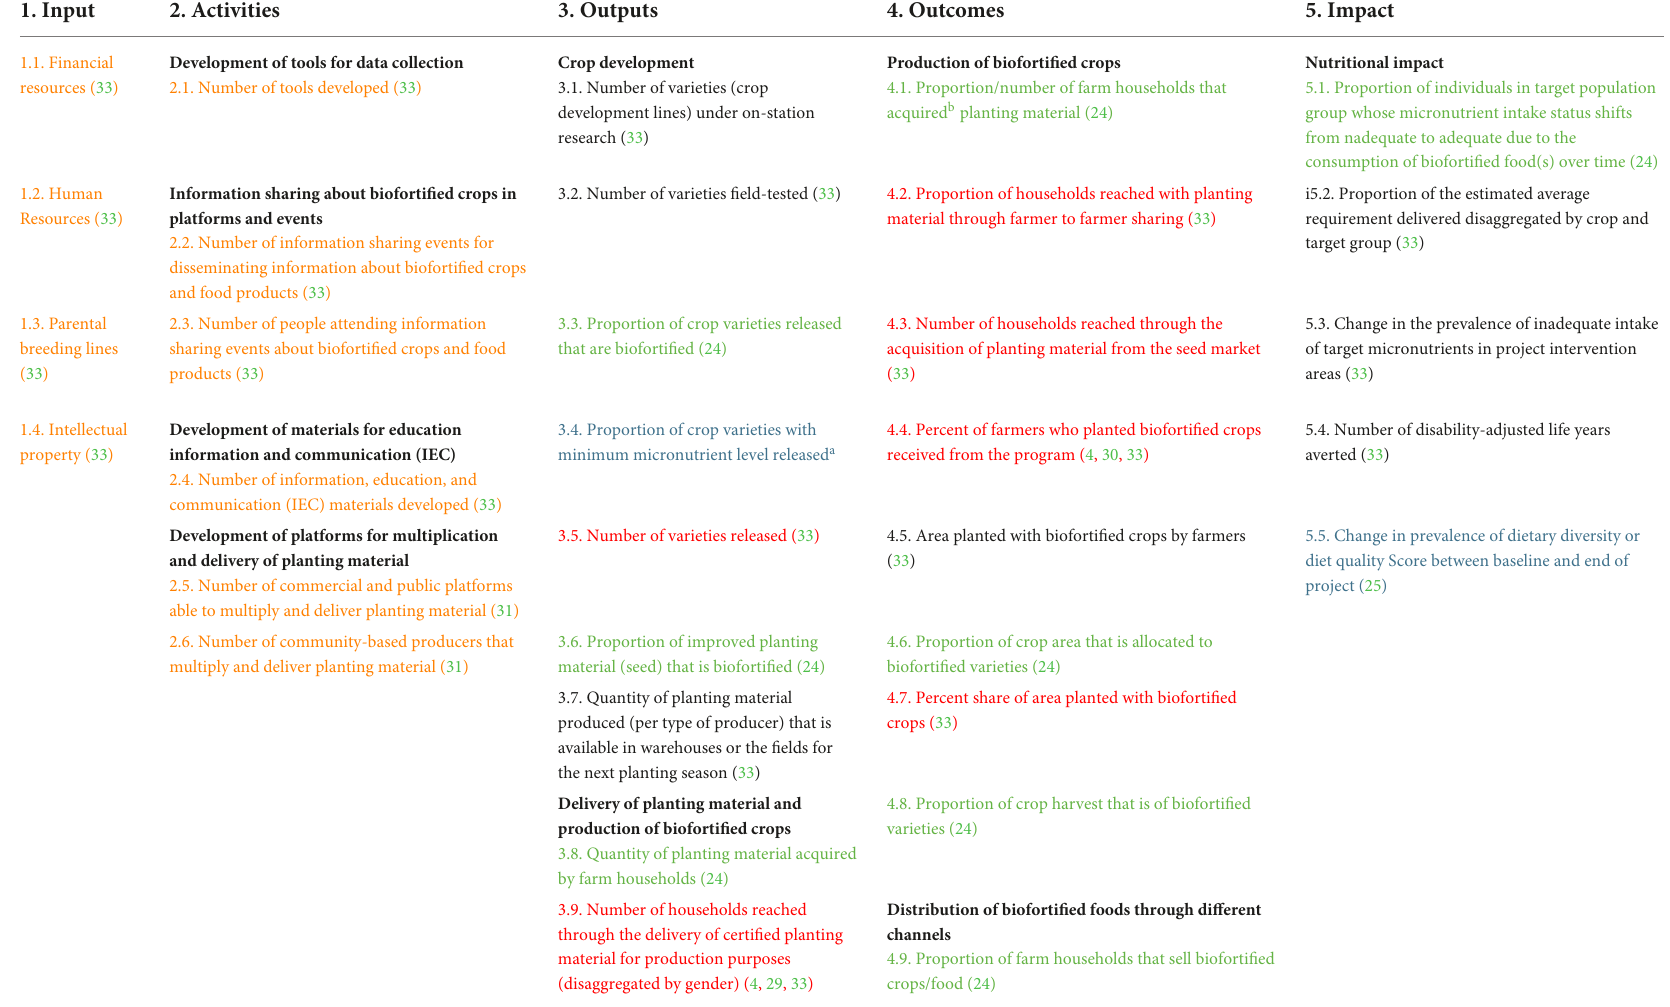
TABLE 4 Total number of indicators ( N = 57), extracted from the mapping review ( n = 36 orange, black and red indicators) merged with the 19 indicators (in green) anchored to the generic ToC from the MELIAS group, one indicator recommended by three HarvestPlus experts, and one indicator extracted from the CIP monitoring and evaluation manual (in blue). 1.